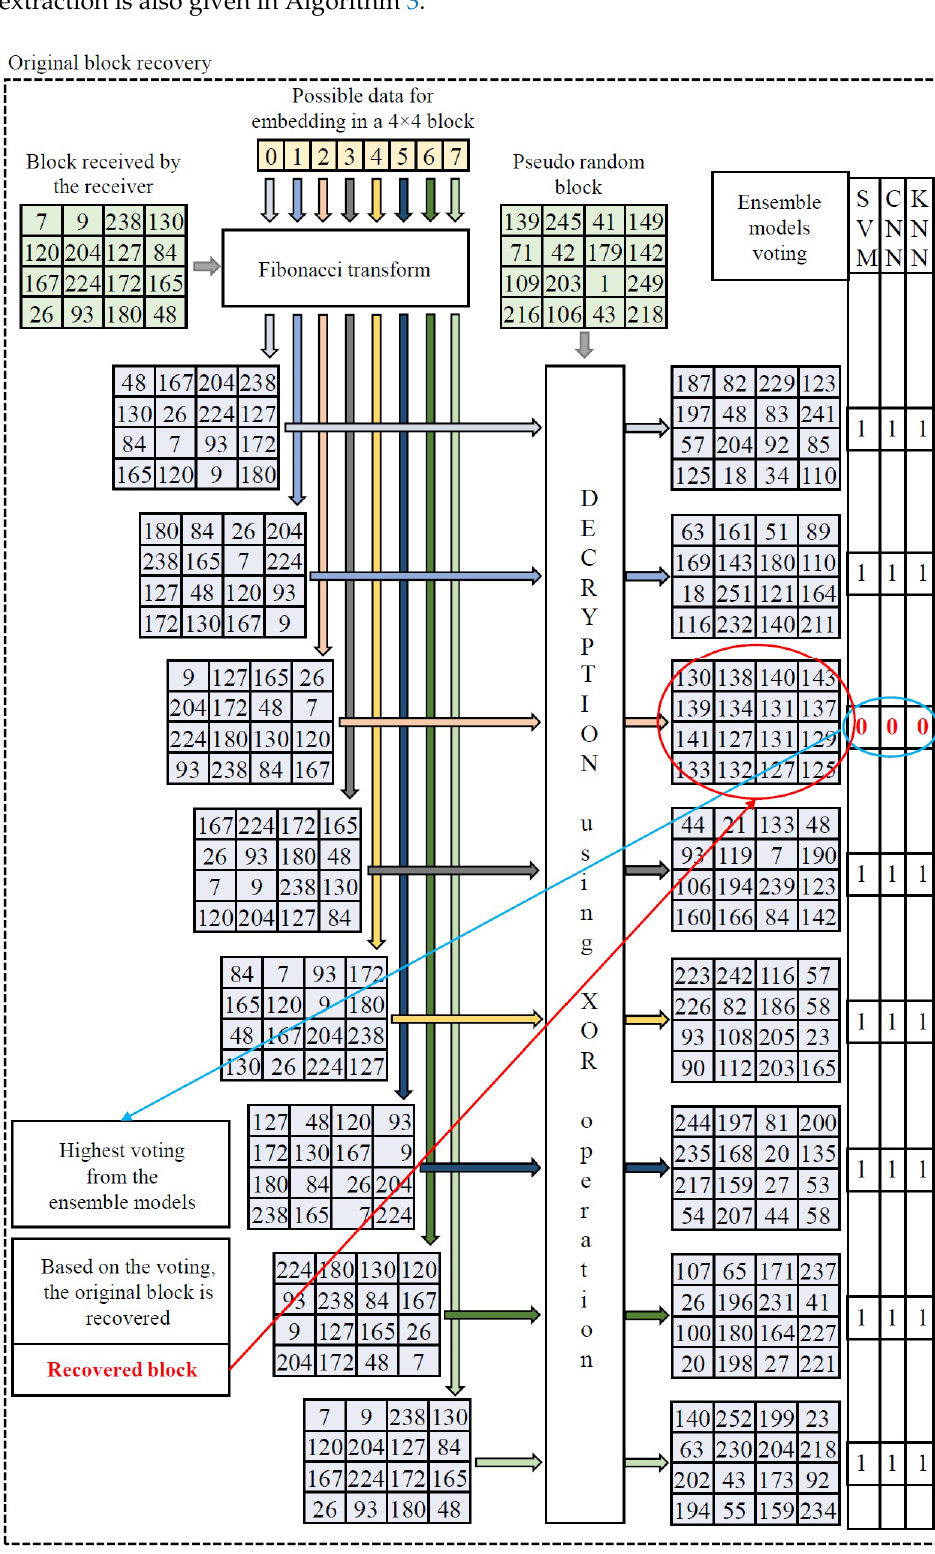
Figure 3. Illustration of original block-recovery